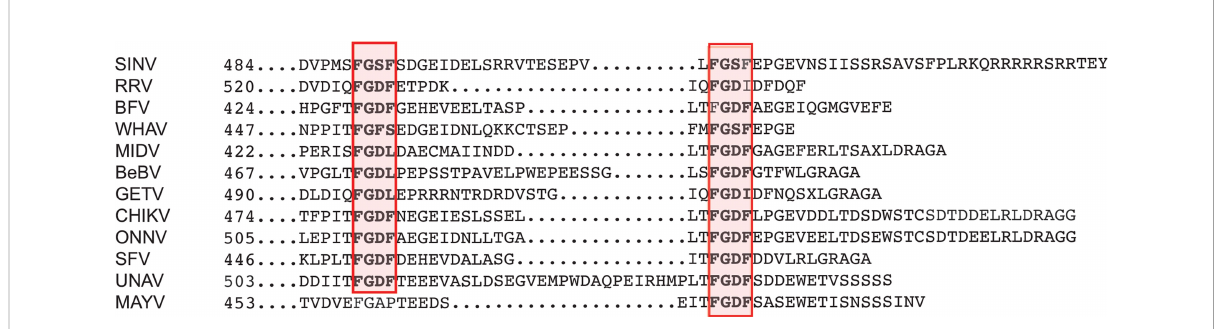
FIGURE 4 Conservation of G3BP canonical binding motifs in Old World alphavirus nsP3. The C-terminal sequence of nsP3 HVD encoded by alphavirus was aligned. The conserved canonical G3BP-binding sequences are boxed in red. SINV, Sindbis virus; RRV, Ross River virus; BFV, Barmah forest virus; WHAV, Whataora virus, MIDV, Middleburg virus; BeBV, Bebaru virus; GETV, Getah virus; CHIKV, Chikungunya virus; ONNV, O ’ nyong ’ nyong virus; SFV, Semliki Forest virus; UNAV, Una virus; MAYV, Mayaro virus.